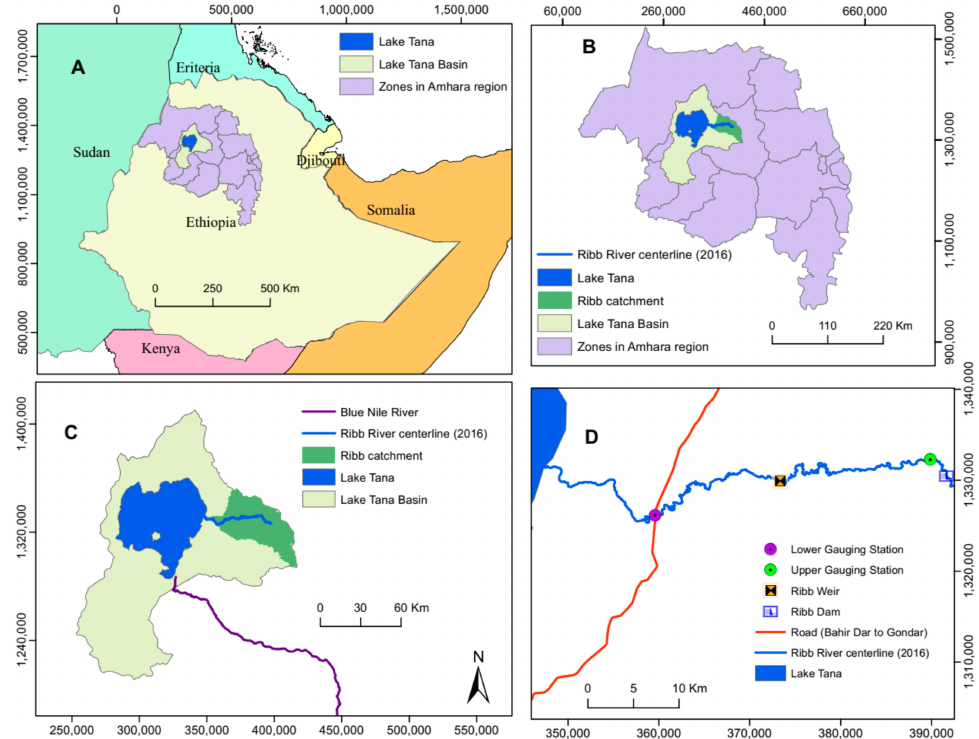
Figure 1. Location map of the study area. ( A ) Ethiopia; ( B ) Amhara region divided in Administrative Zones; ( C ) Lake Tana basin highlighting Lake Tana, Blue Nile River and Ribb River catchment; ( D ) studied river reach including Ribb dam, Ribb weir, Upper and Lower gauging stations, and the 2016 river centerline.